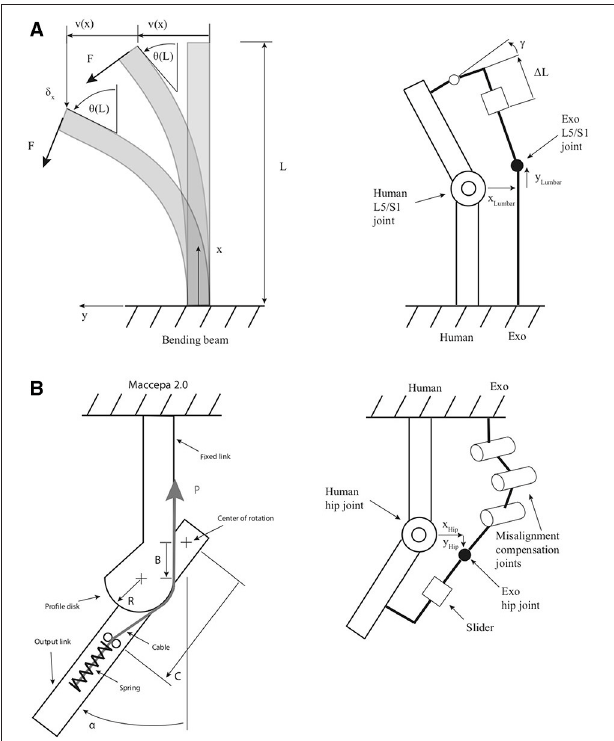
FIGURE 3 | Spinal support concept (A) . The lumbar joint of the exoskeleton consists of a flexible beam, which serves at the same time as a torque source. On the beam of length L acts a force F at the top. This leads to a displacement v ( x ) which is a function of the position along the beam x . With increasing bending angle θ ( L ) the displacement at the top δ x along the x-axis becomes more pronounced; The misalignment compensation mechanism for the trunk asserts, that despite a misalignment of x Lumbar and y Lumbar no relative movement ( 1 L ) or angular discrepancies persist ( γ ); Hip support concept (B) . The flexion extension joint is powered with a Maccepa 2.0 ( Vanderborght et al., 2011), which consists of a profile disk over which a cable is tensioned. The movement of the output joint by angle α compresses a spring and thereby stores energy. The pretension P is altered with a worm gear. The main design parameters are an offset B from the center of rotation, (here) a fixed profile radius R and the length C ; The misalignment compensation of the hip asserts kinematic compatibility with additional three parallel joints and a slider.